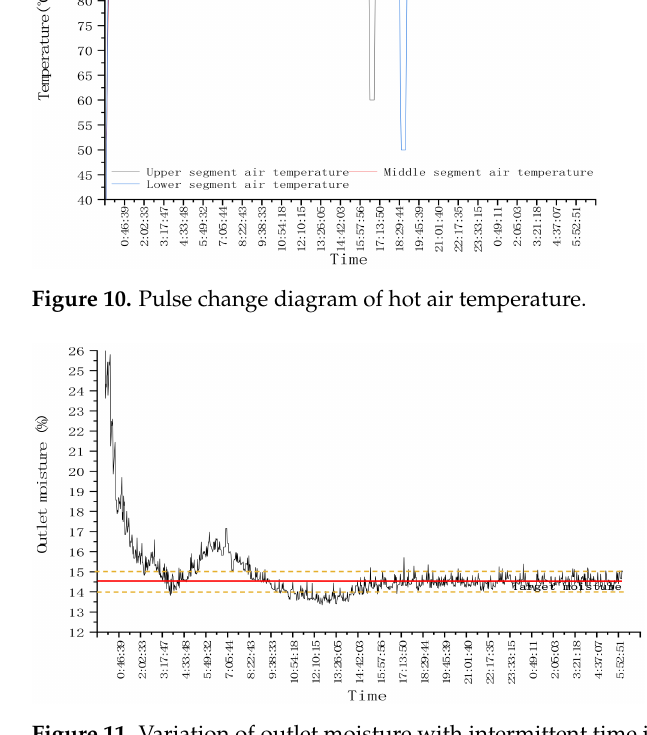
Figure 11. Variation of outlet moisture with intermittent time in the drying